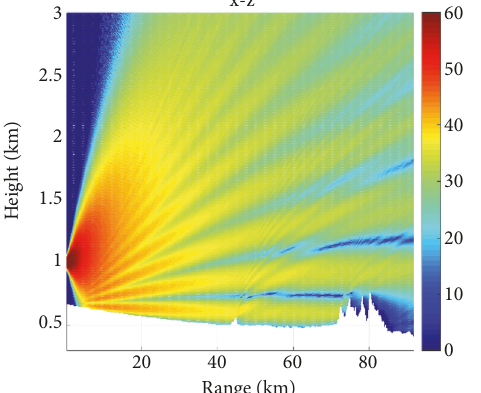
Figure 13: Electric field distribution in dB at frequency of 60 MHz.